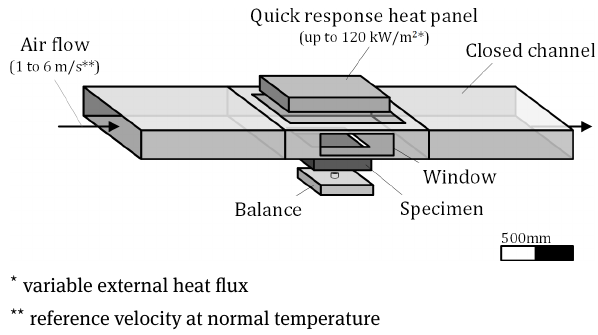
Figure 5: Heat transfer elements contributing to superimposed heat flux ˙ q sum relevant for the charring rate β st . Figure 6: The Fire Apparatus for Non-standard heating and Charring Investigation